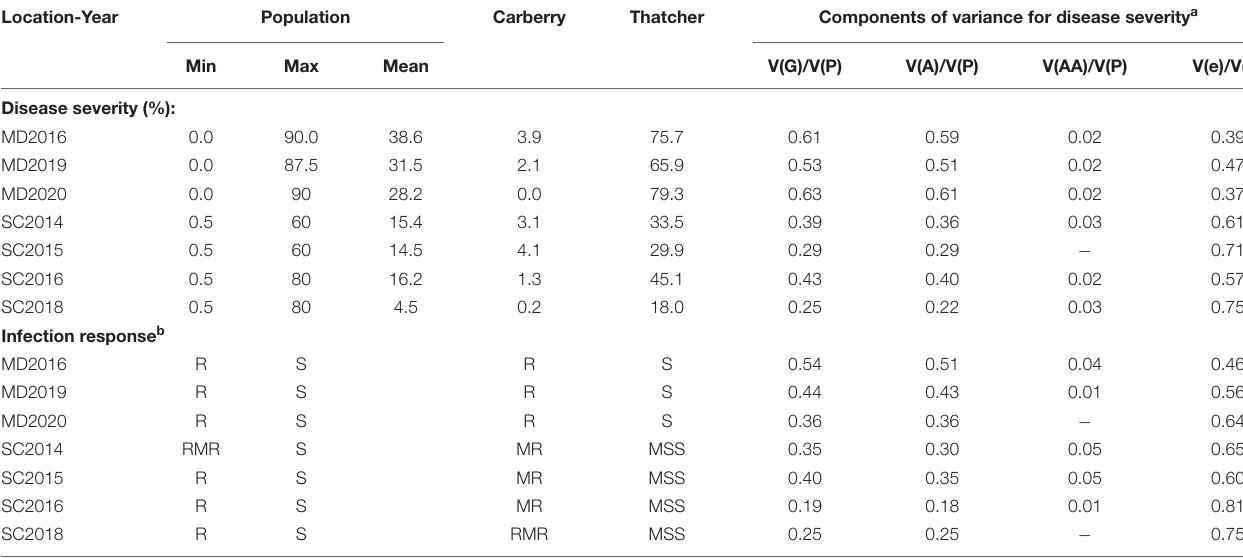
TABLE 3 | Mean and range of the leaf rust severity and infection response scores for the Carberry/Thatcher doubled haploid (DH) population and parents and heritabilities from field nurseries near Morden (MD), MB for 3 years, and Swift Current (SC), SK for 5 years. Location-Year Population Carberry Thatcher Components of variance for disease severity